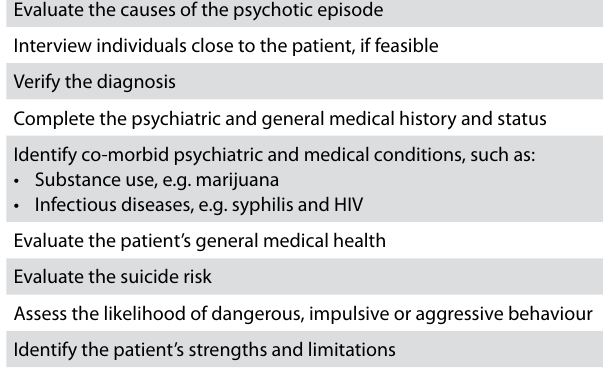
Verify the diagnosis